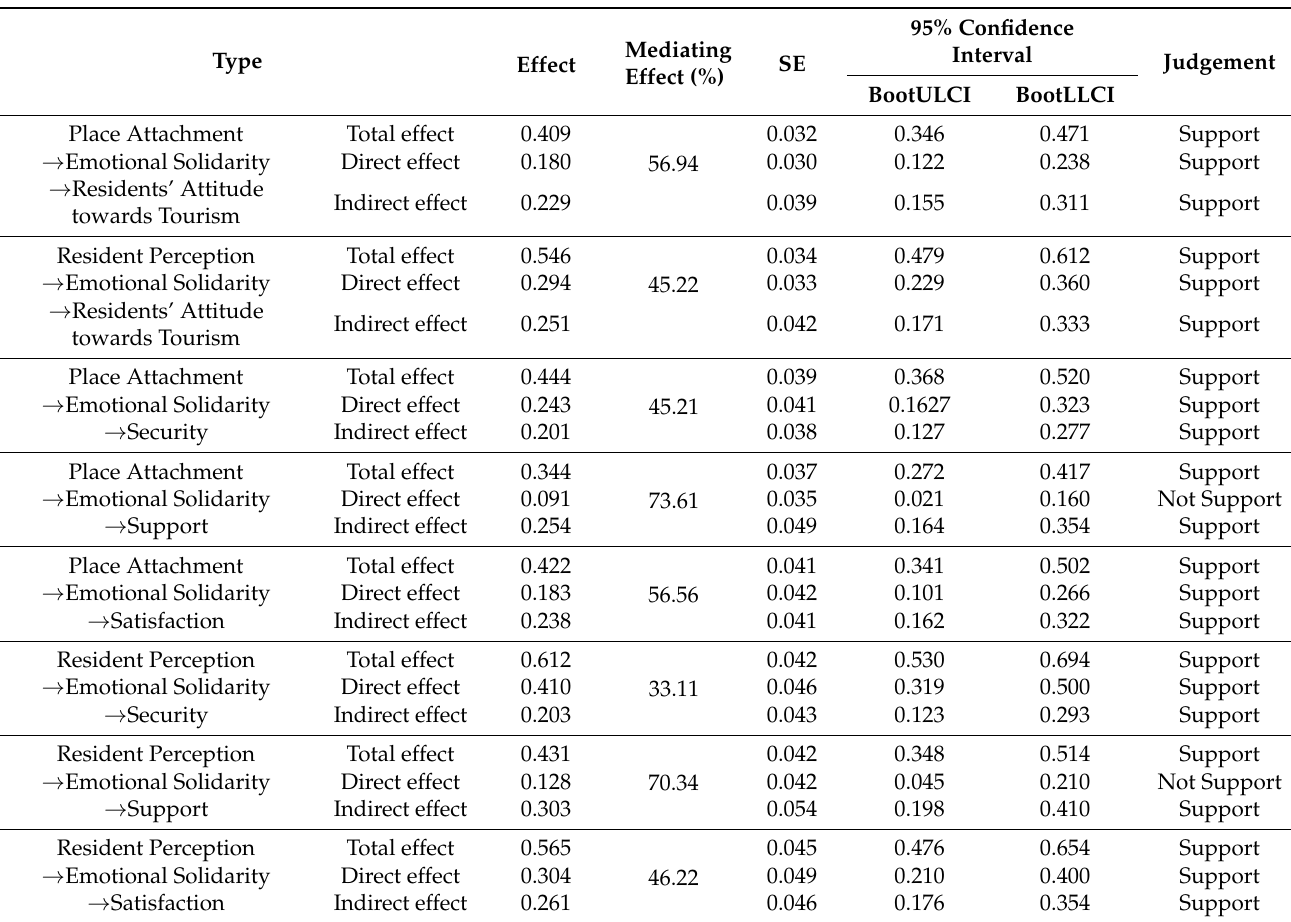
Table 5. Results of total effect, direct effect and mediating effect.